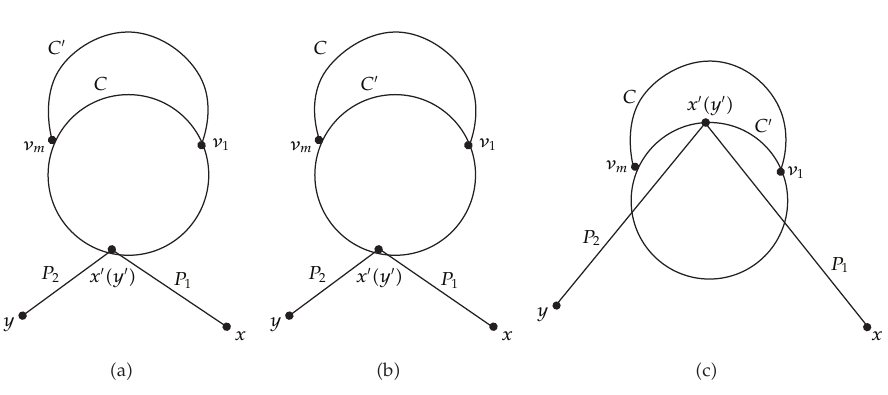
Figure 2: Illustrate for Subcase 1 . 2 . 1 of Lemma